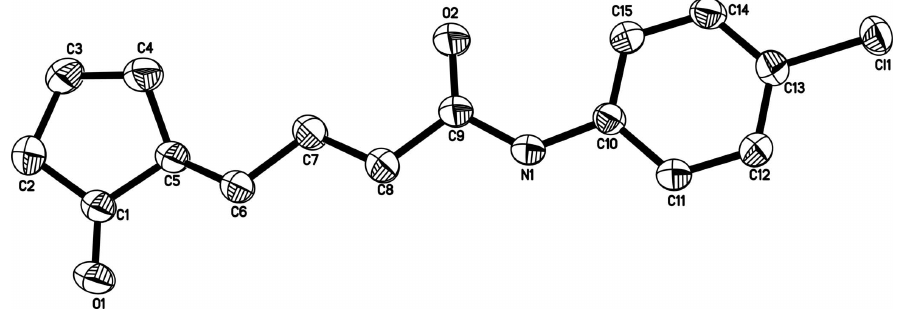
The molecular structure of the title compound, showing 30% probability displacement ellipsoids and the atomic numbering. H atoms have been omitted for